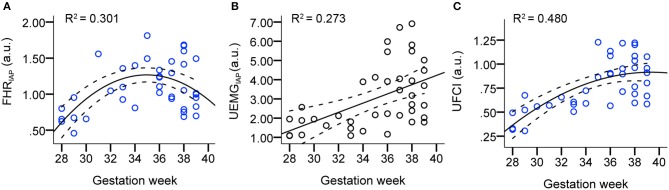
Scatter plots and linear/quadratic regression lines of FHRIAP
(A), UEMGIAP
(B), and UFCI (C) in dependency on gestation age for the AGA fetuses between 28 and 39 weeks. Note that the bold lines are quadratic mean fitted values, and dashed lines are 95% confidence intervals.